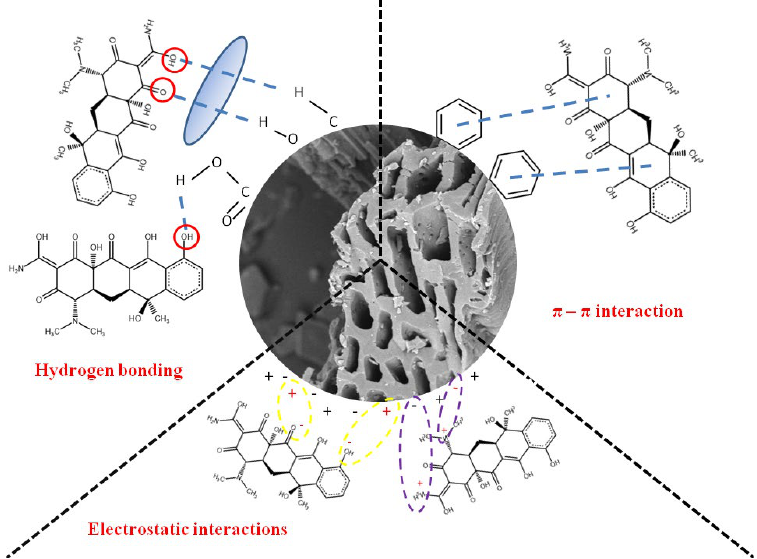
Figure 6. Mechanisms of TC adsorption on biochars.